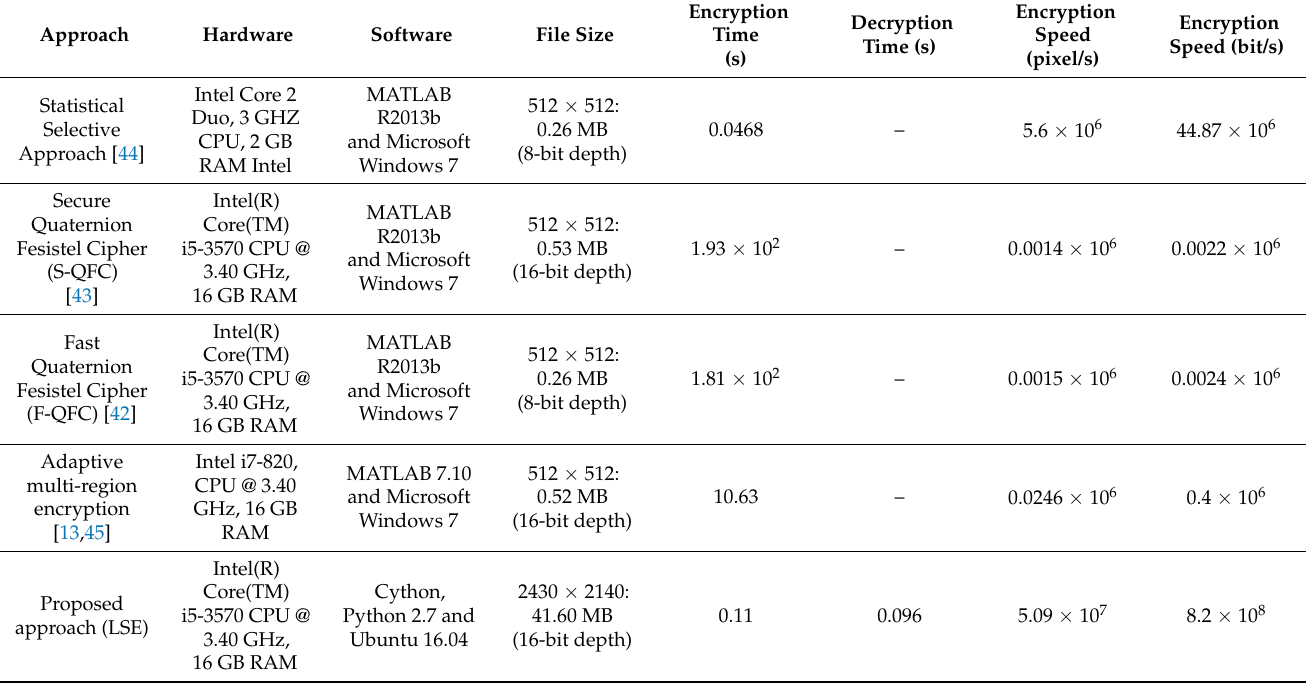
Table 2. Brief comparison of the encryption time with approaches reported in the